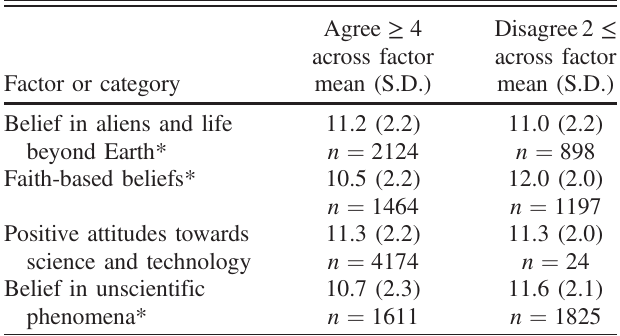
TABLE IX. Average science knowledge scores of students with average factor scores at or more extreme than “ agree ” or “ disagree ” for each category.